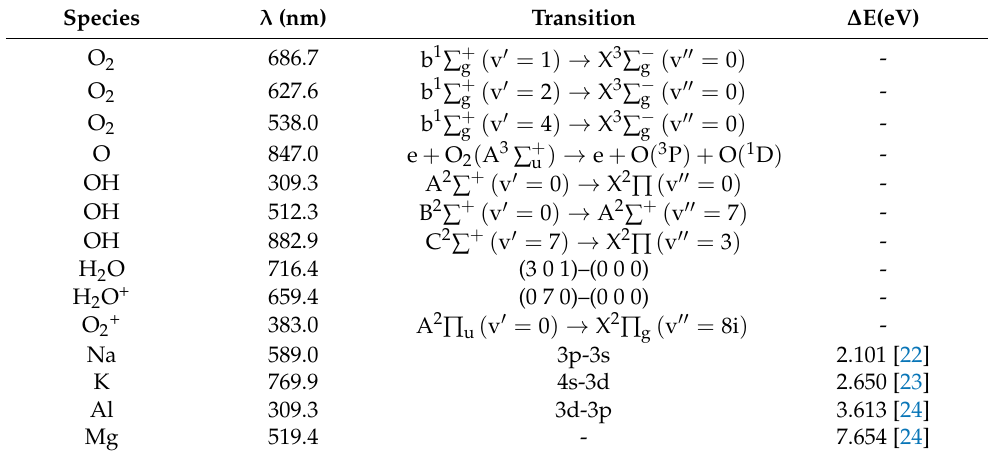
Table 1. List of the observed molecular bands, the corresponding transitions, and the wavelengths. Species λ (nm)